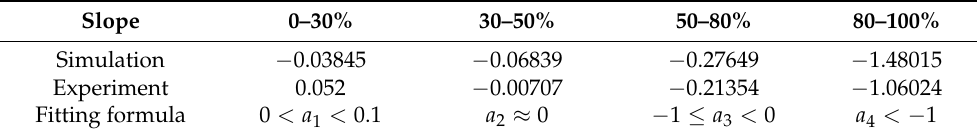
Figure 16. Comparison of the C40 concrete test and simulated coda wave velocity change rate. Table 6. Comparison of the simulation results and test results of C40 concrete uniaxial